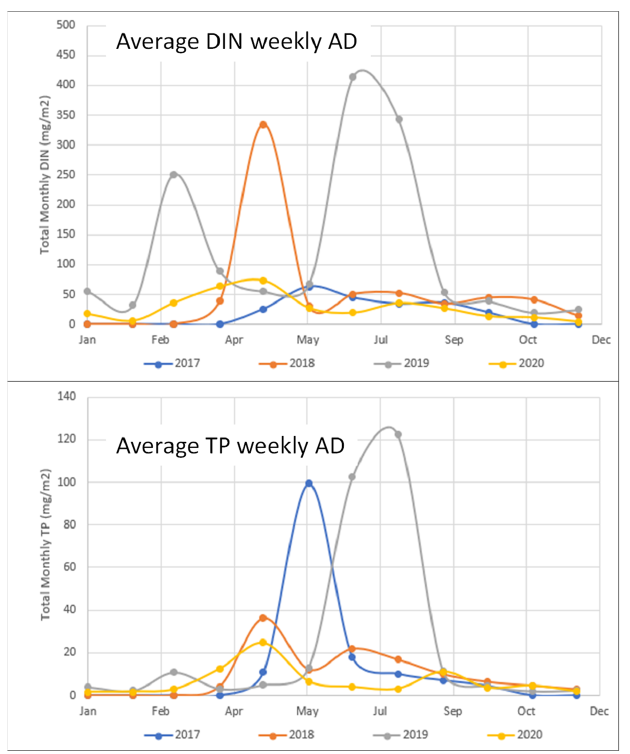
Figure 13. Monthly average of weekly AD for DIN and TP in the top and bottom panels, respectively. Values are in mg/m 2 /week. Table 6. Monthly average of weekly DIN AD (mg/m 2 /week) 1 .